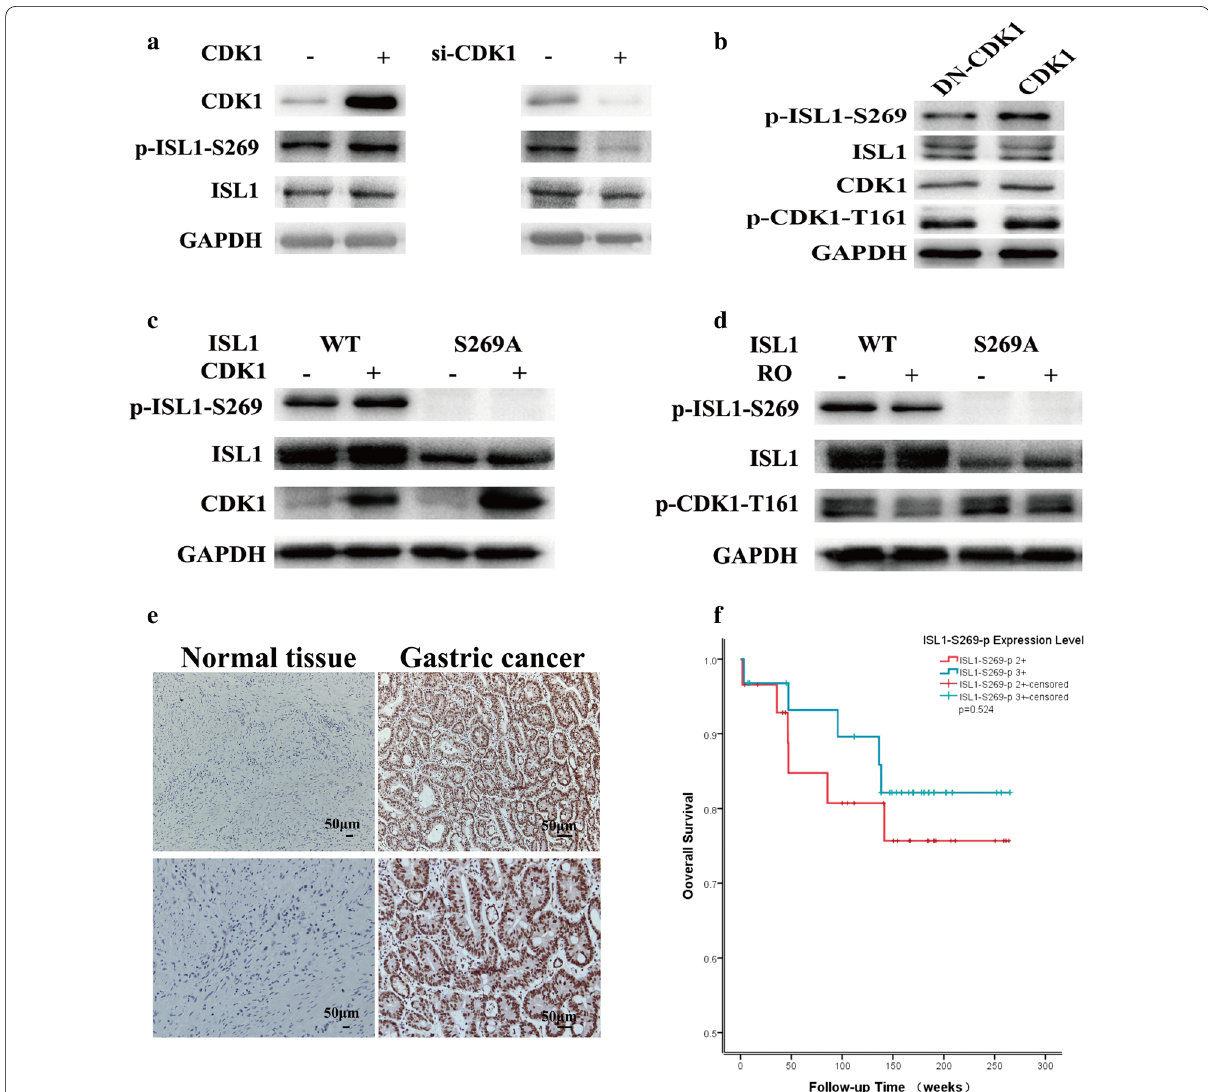
Fig. 3 CDK1 mediates ISL1 phosphorylation at serine 269. a MGC803 cells transfected with plasmid encoding CDK1 or control vector (left), negative control or CDK1 si-RNA (right). Lysate was analyzed by immunoblotting with antibodies against the indicated proteins. b MGC803 cells were transfected with plasmids encoding dominant-negative mutant CDK1 (DN-CDK1) or CDK1, and lysate was analyzed by immunoblotting with antibodies against the indicated proteins. c MKN28 cells expressing wild-type ISL1 or ISL1-S269A were transfected with plasmid encoding CDK1 or control vector. Cell lysates were immunoblotted with antibodies against the indicated proteins. d MKN28 cells were transfected with plasmids encoding wild-type ISL1 or ISL1-S269A and treated with CDK1 inhibitor RO-3306 or DMSO. Lysates were analyzed by immunoblotting with antibodies against the indicated proteins. GAPDH served as the internal control. e Representative IHC staining of ISL1-S269-p expression in GC (right, n 60) and paired adjacent tissues (left, n 60). f Relationship between expression of ISL1-S629-p and overall survival in gastric = =